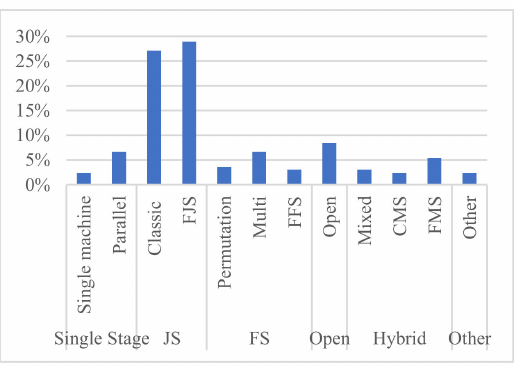
Figure 24. Percentage of different types of layouts in the